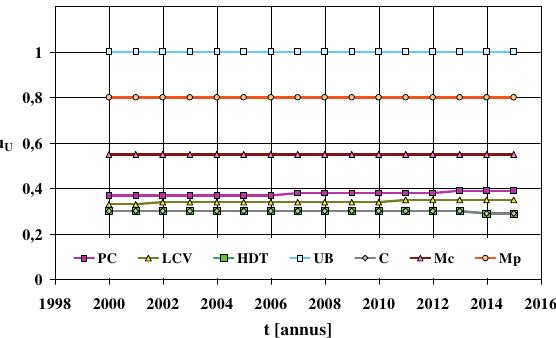
Fig. 3. Share of mileage by vehicles per cumulated category, under model traffic conditions: urban